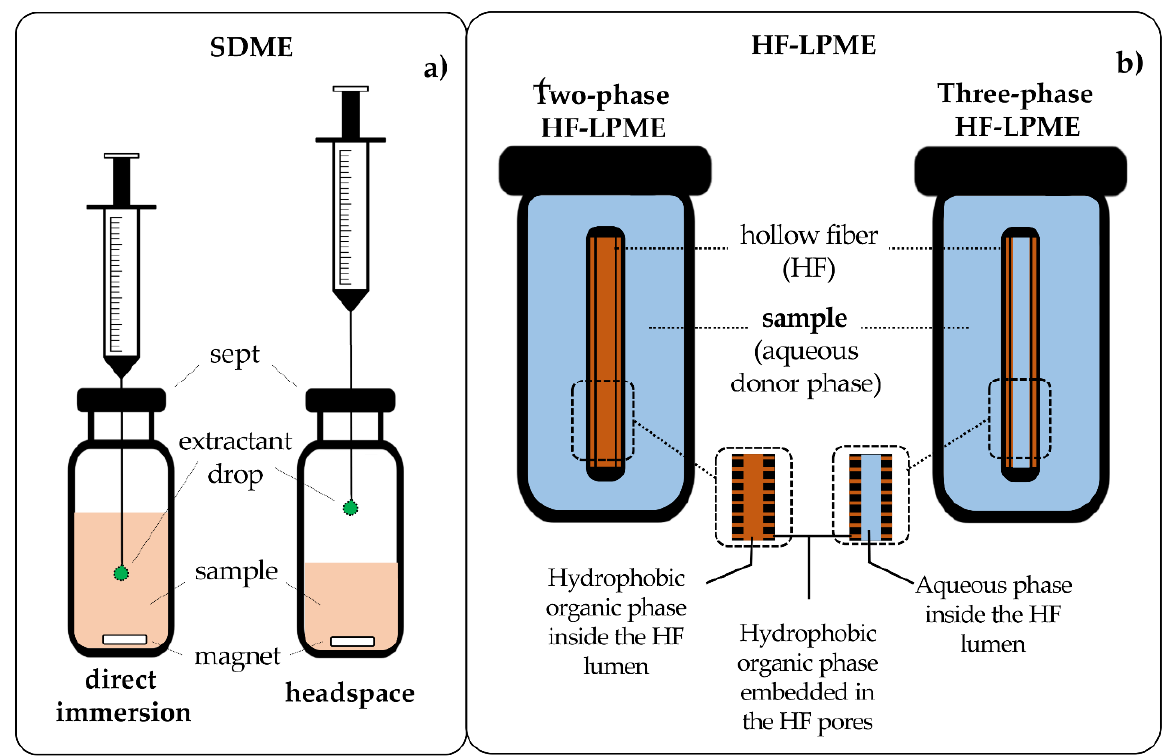
Figure 5. Schematic representation of direct immersion and headspace modes of single ‐ drop microextraction (SDME) ( a ) and two ‐ and three ‐ phase modes of hollow fiber liquid ‐ phase microextraction (HF ‐ LPME) ( b ).